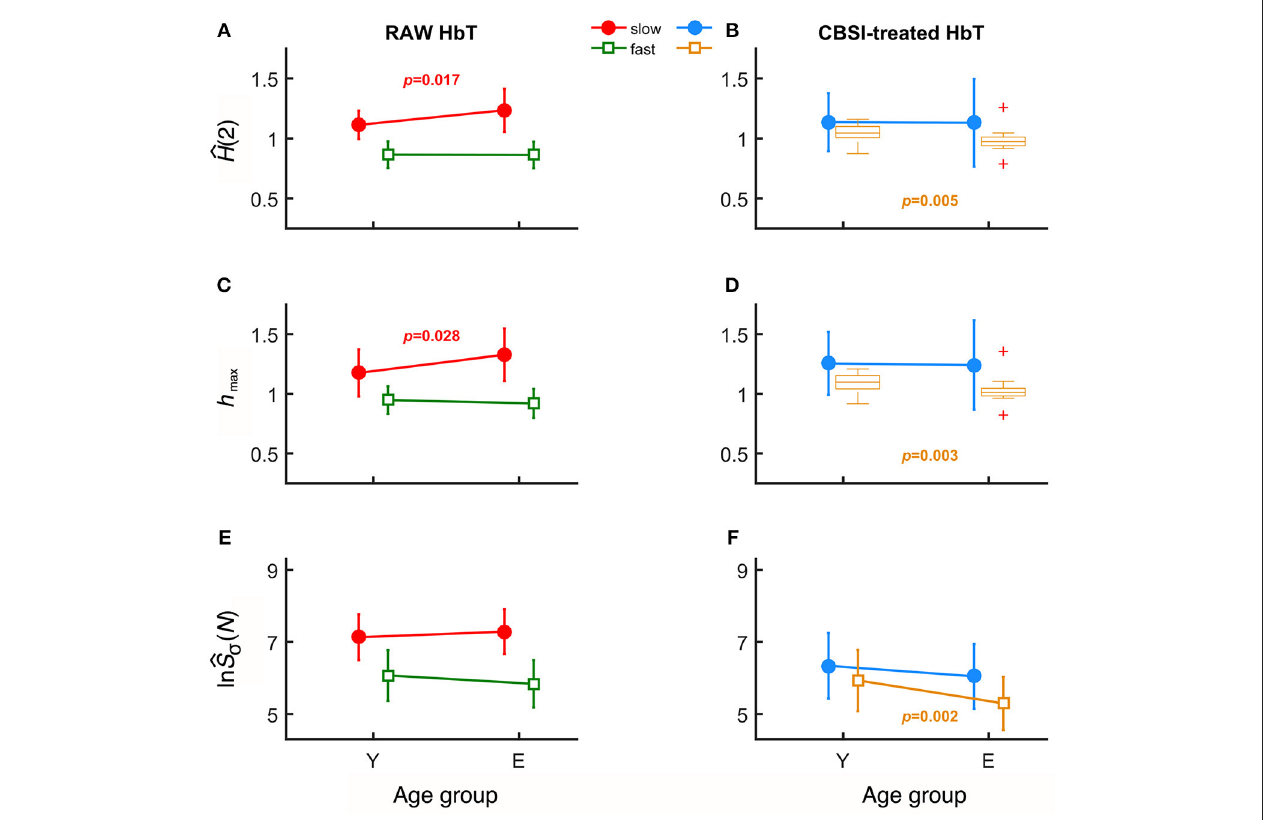
FIGURE 3 | Results of univariate statistical analysis of multifractal endpoint parameters. ˆH (2) of slow and fast components in the two age groups calculated from raw (A) and on CBSI-pretreated (B) HbT signals. h max obtained from raw (C) and CBSI-treated (D) HbT signals. Focus of raw (E) and CBSI-pretreated (F) HbT signals. Recall that the raw HbT signal represents neuronal and non-neuronal events combined, while the CBSI-pretreated signal is a enhanced representation of the underlying neurodynamics. Accordingly, the fact that we found significant differences in the slow component for the raw HbT signal and in the fast component for the CBSI-pretreated signals identifies the slow component emerging dominantly from vascular events, while the fast component attributed mainly to